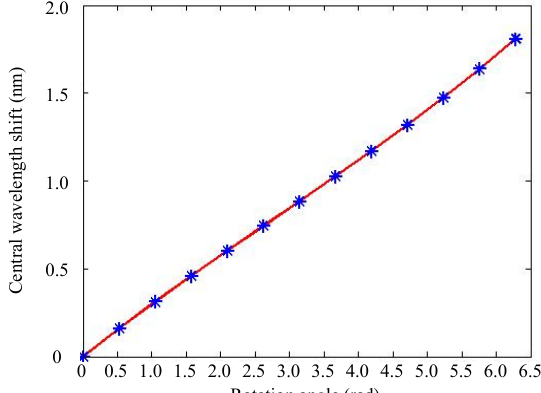
Fig. 7 Corresponding relationship between the wavelength shifts and rotation angle.